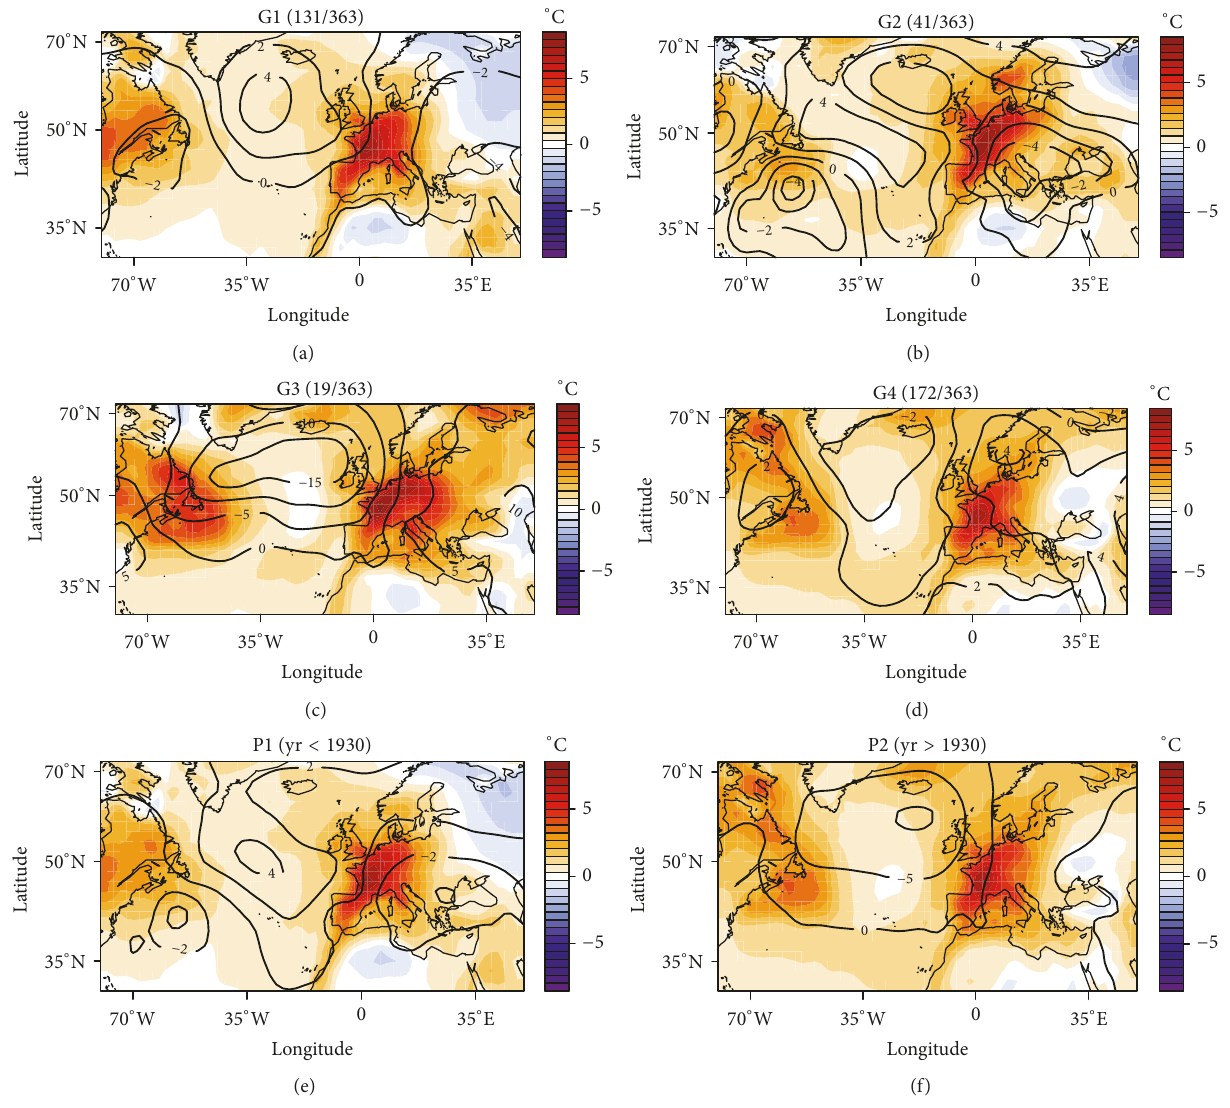
Figure 6: Composites of sea-level pressure (SLP) and surface temperature (SAT) anomalies during heatwaves events. In (a)–(d), composites SLP (hPa) and SAT ( ∘ C) anomalies for all the days during heatwaves events in each period, from G1 to G4; in (e), anomalies for all the days during heatwaves events before 1930 and (f) after